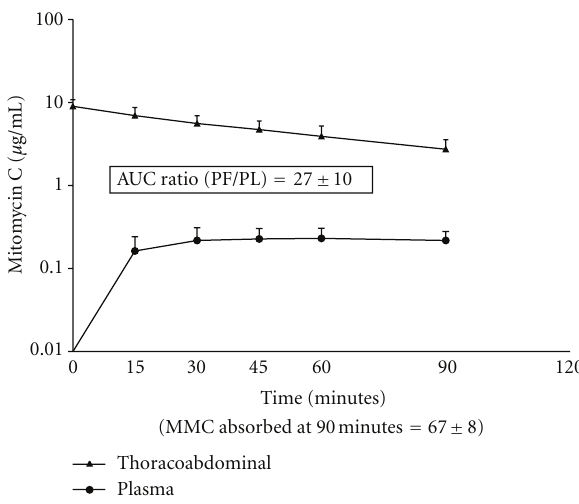
Figure 1: Pharmacokinetics of mitomycin C in 12 patients with simultaneous intraabdominal and intrathoracic chemotherapy used in conjunction with cytoreductive surgery.